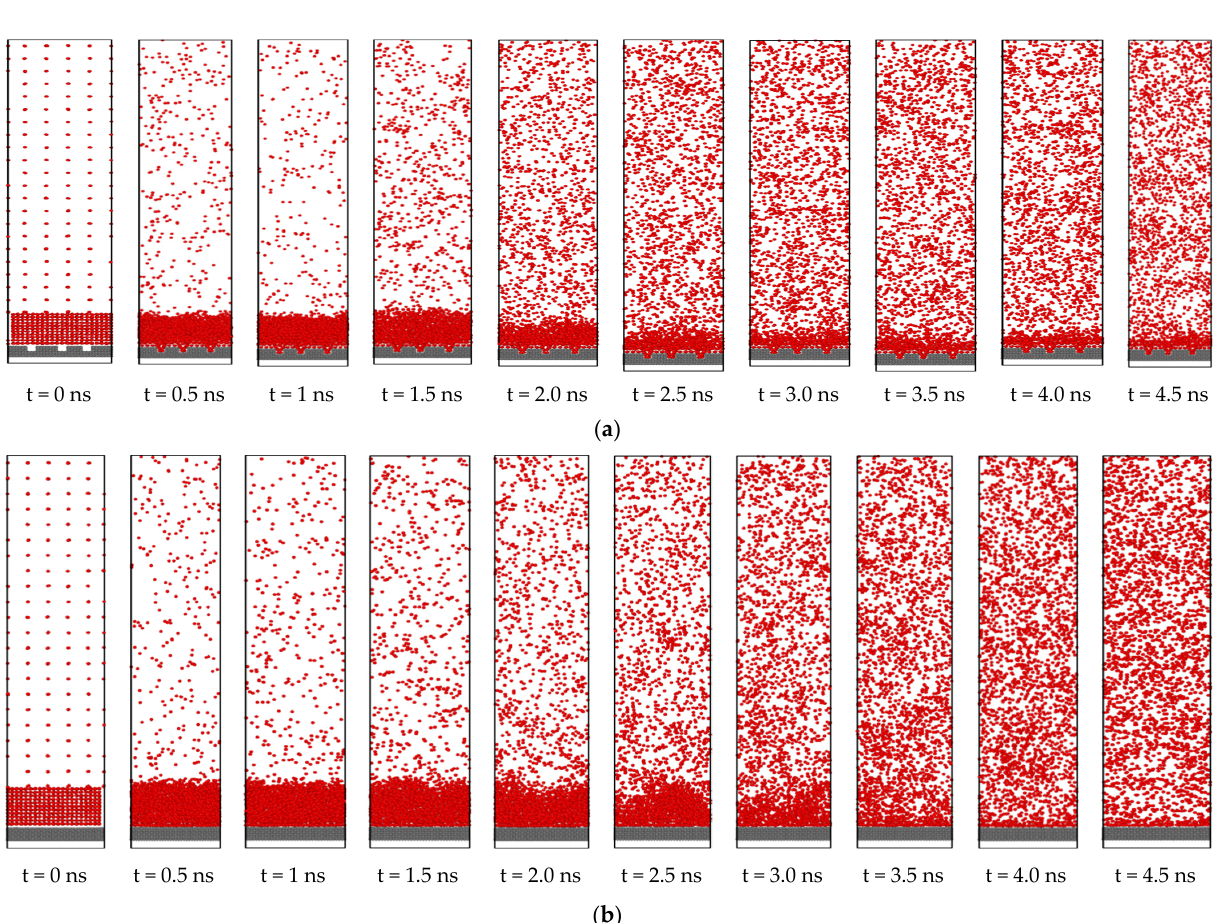
Figure 15. Comparison of temperature history of the argon atoms for a surface having nano slots with a smooth surface.